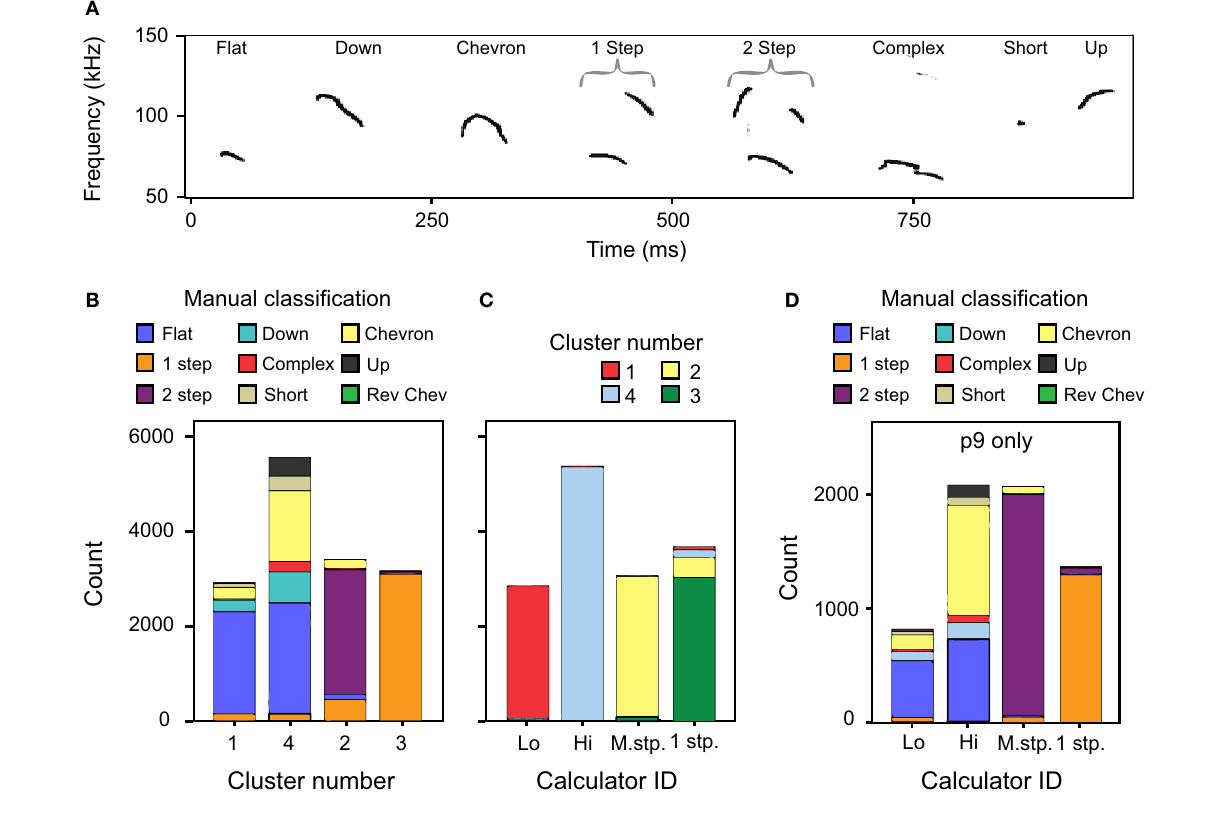
c1 and c4. (C) Comparison between cluster analysis classification and the mouse syllable classification calculator for all ages except p9. (D) Comparison between manual classification and the mouse syllable classification calculator for a novel data set of calls emitted by p9 pups. These syllables were not used in the two-step cluster analysis that defined the number of syllable